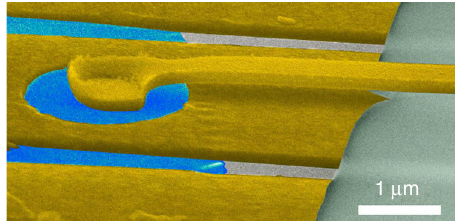
Fig. 1 Suspended graphene Corbino disk. Scanning electron micrograph of a 2- μ m-diameter graphene Corbino sample (XD) with 700 nm diameter circular middle contact; blue denotes the suspended graphene and gold/ chromium contacts appear as grayish yellow. See the Supplementary Note 1 for detailed